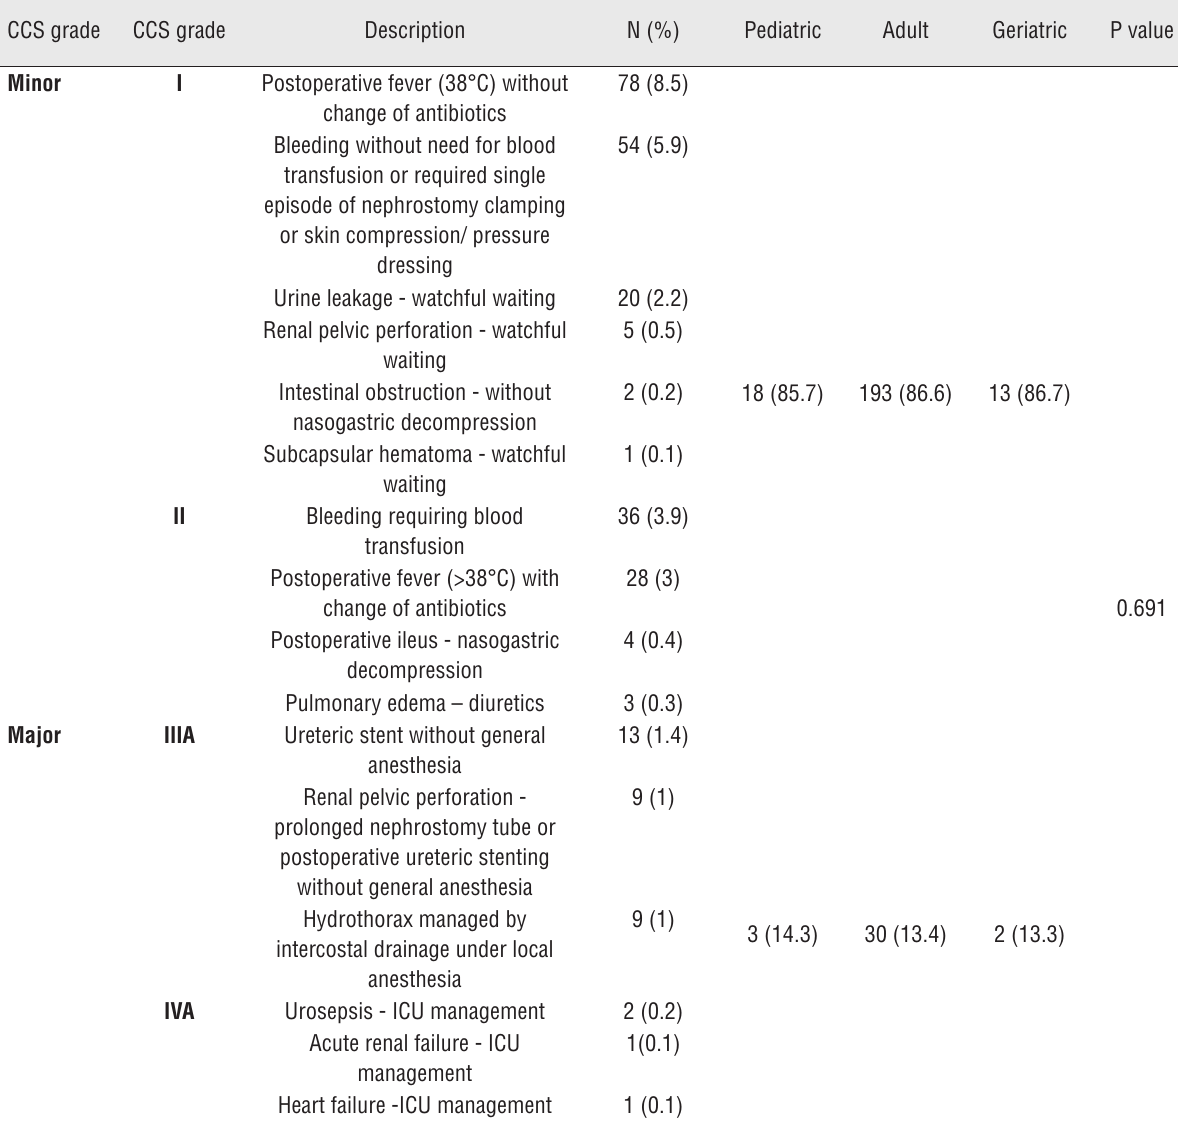
Table 2 - clavien-cROEs complications – overall and based on age